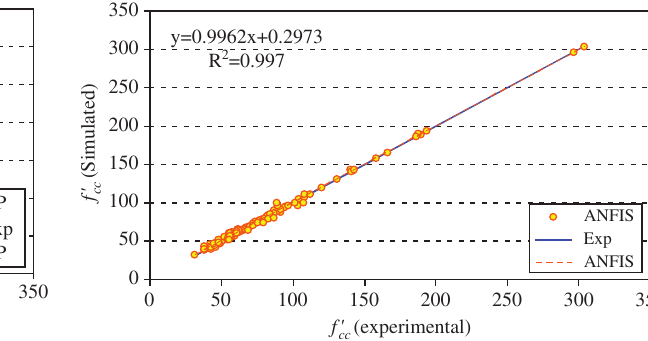
Figure 14 Predictions of the GP model against experimental data.